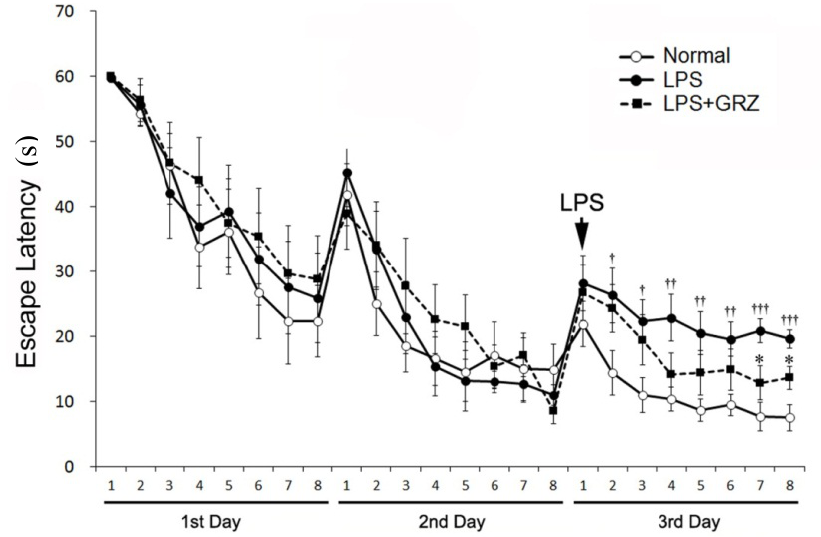
and 2nd day were not different among the normal, LPS, and LPS + GRZ groups (F p = 0.723; F = 0.13, p = 0.882; respectively). The LPS + GRZ group showed 2,21 significantly shorter escape latency at the 7th and 8th trials on the 3rd day, while the escape latency for the total trials on the 3rd day was significantly different from the LPS group = 1.98, p = 0.181). Data are represented by mean ± SEM (n = 12 in each group; (F 1,14 † p < 0.05; †† p < 0.01; ††† p < 0.001 compared to the normal group; * p < 0.05 compared to the LPS